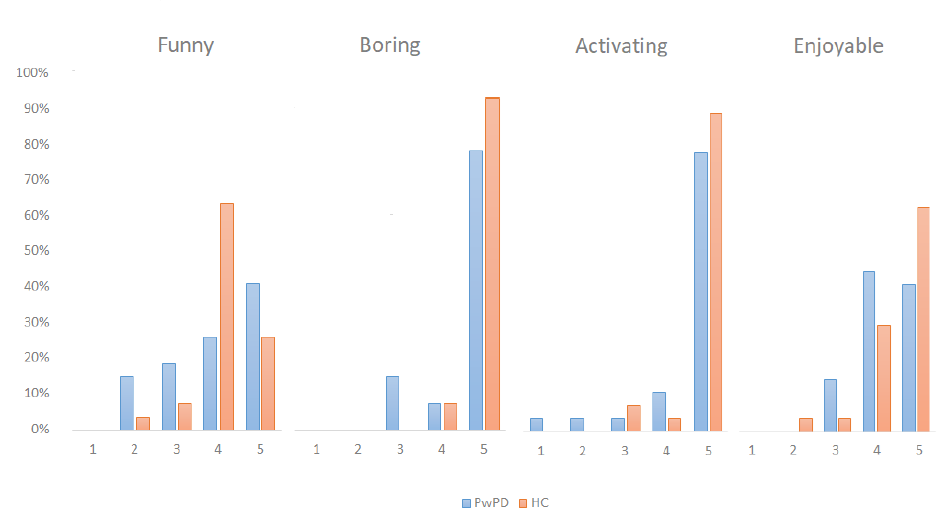
Figure 6. Graphic representation of the Intrinsic Motivation Inventory domains, comparing patients and controls.